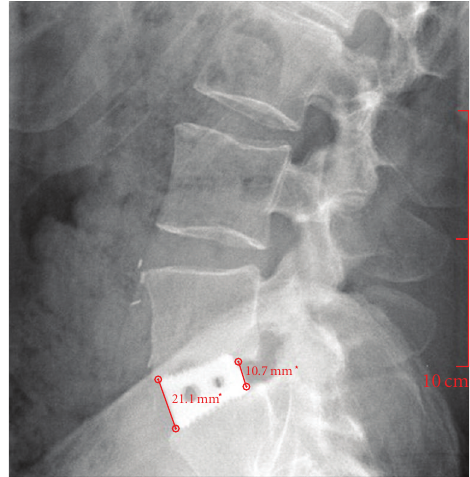
Figure 3: Measurement of digital X-ray.